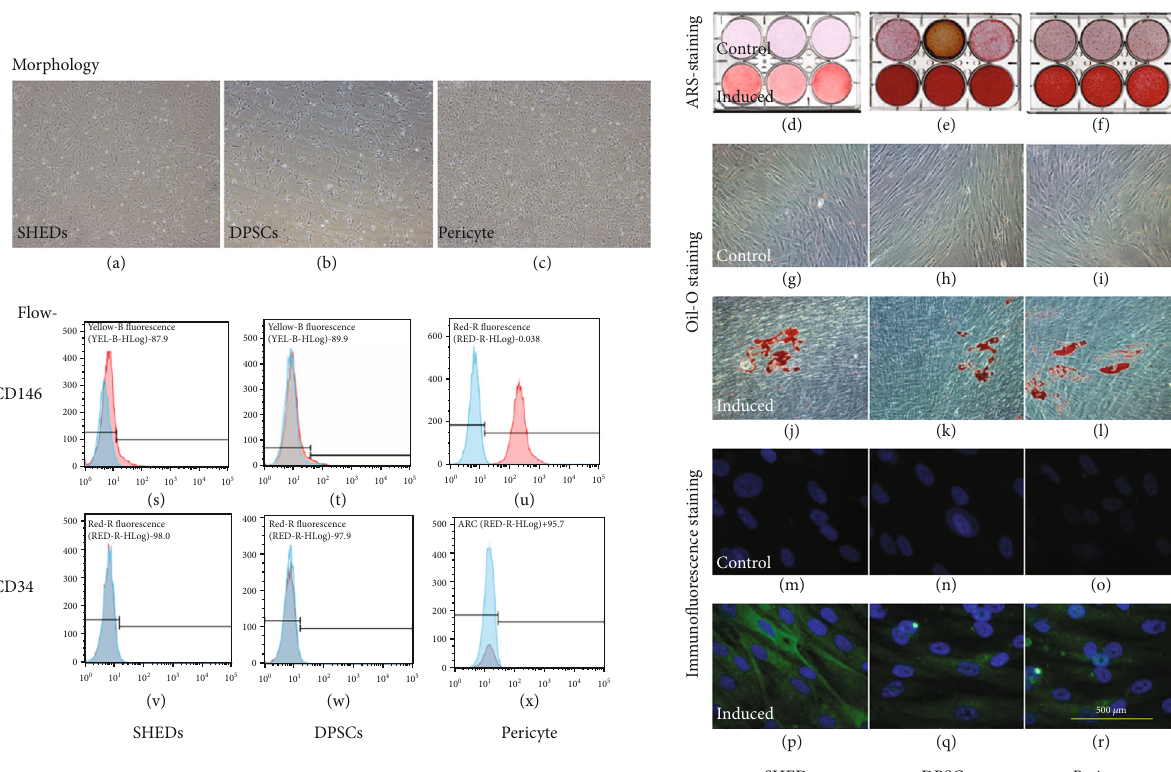
Figure 1: Cell culture and identi fi cation. (a – c) pericytes, postnatal human dental pulp stem cells (DPSCs), and stem cells from human exfoliated deciduous teeth (SHEDs) showed similar morphological features under an inverted microscope. (d – f) Alizarin-red staining assay. (g – l) Oil red O staining assay. (m – r) Neurogenic di ff erentiation